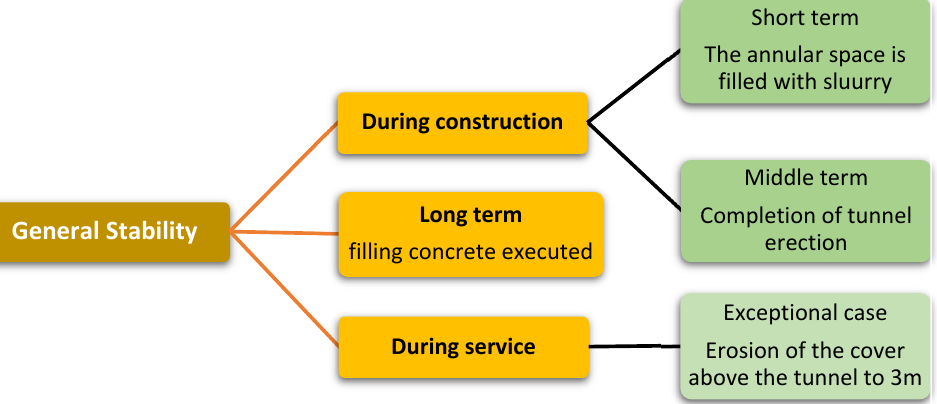
Figure 8. Tunnel general stability flowchart according to the empirical model. For the short-term case,